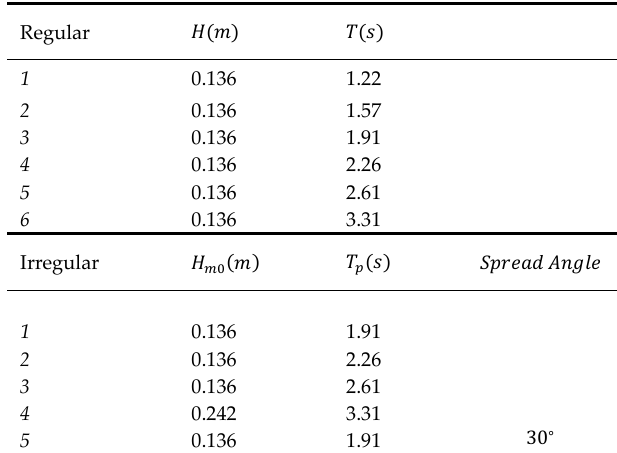
layout in the top row and the optimal layout in the bottom row. The bar plots show the average of three runs corresponding to the three bridge positions. The error bars show the max and min values of the average power resulting from the three bridge positions. repeatability is quite good for all cases. In the bar plot,